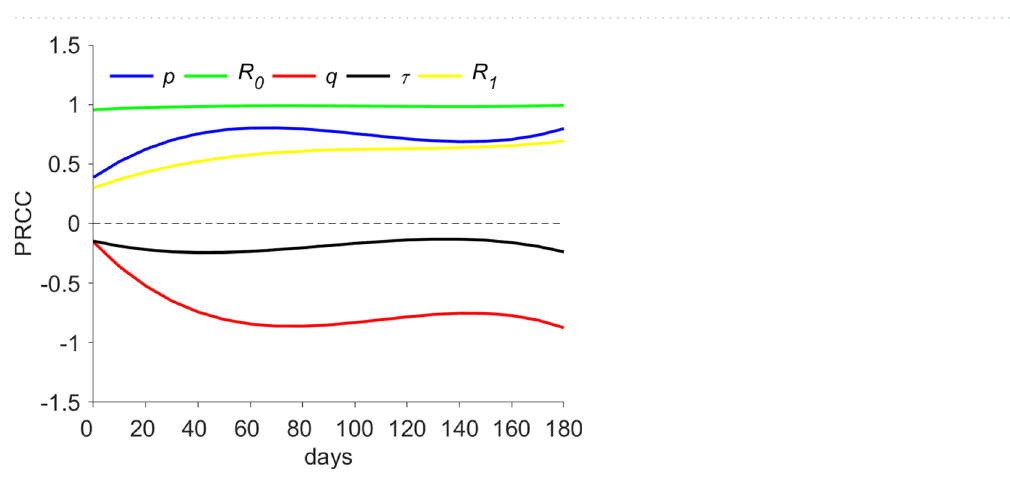
Figure 3. Results of continuous-time sensitivity